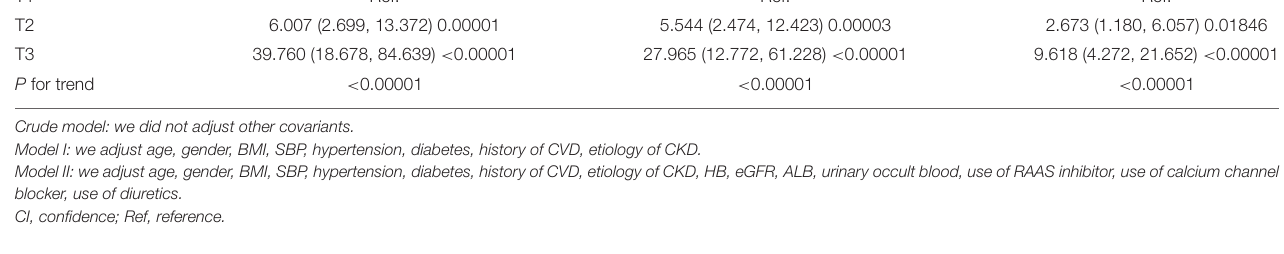
Figure 6 illustrated the effect of the baseline UPCR group on the longitudinal changes of eGFR. While stratified based on the tertiles of UPCR, the association between UPCR and eGFR changes was correspondingly divided into three parts. As UPCR was negatively correlated with eGFR, the patients with the lowest tertile of UPCR at baseline had the highest levels of eGFR at baseline and during follow-up. However, eGFR decreased